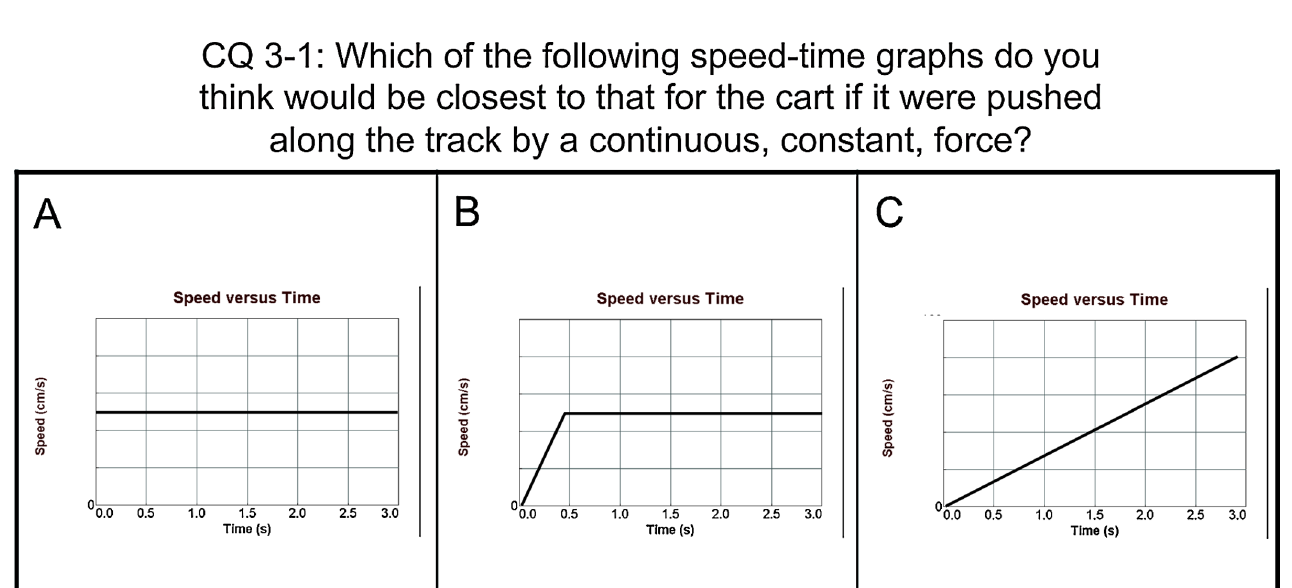
FIG. 12 (color online). First clicker question in